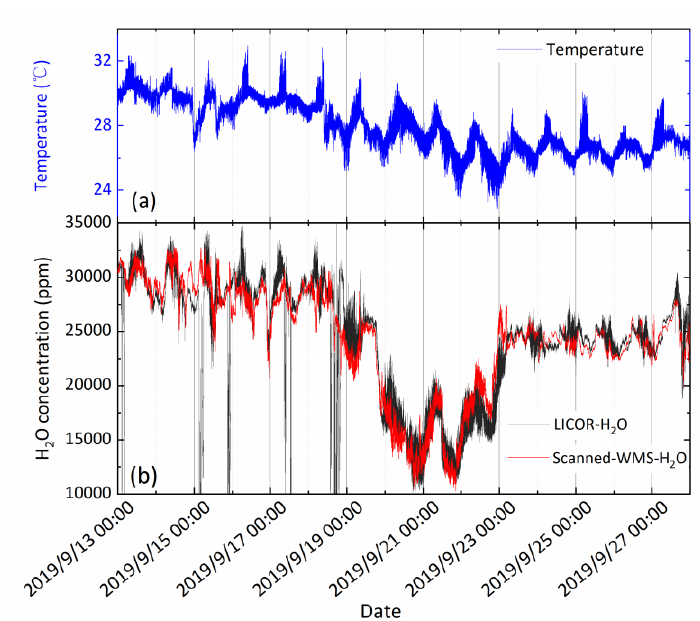
Figure 13. ( a ) Temperature data series over half a month period and ( b ) a comparison of atmospheric H 2 O vapor data series from LICOR analyzer and our scanned-WMS- θ 1f sensor over the same time period.